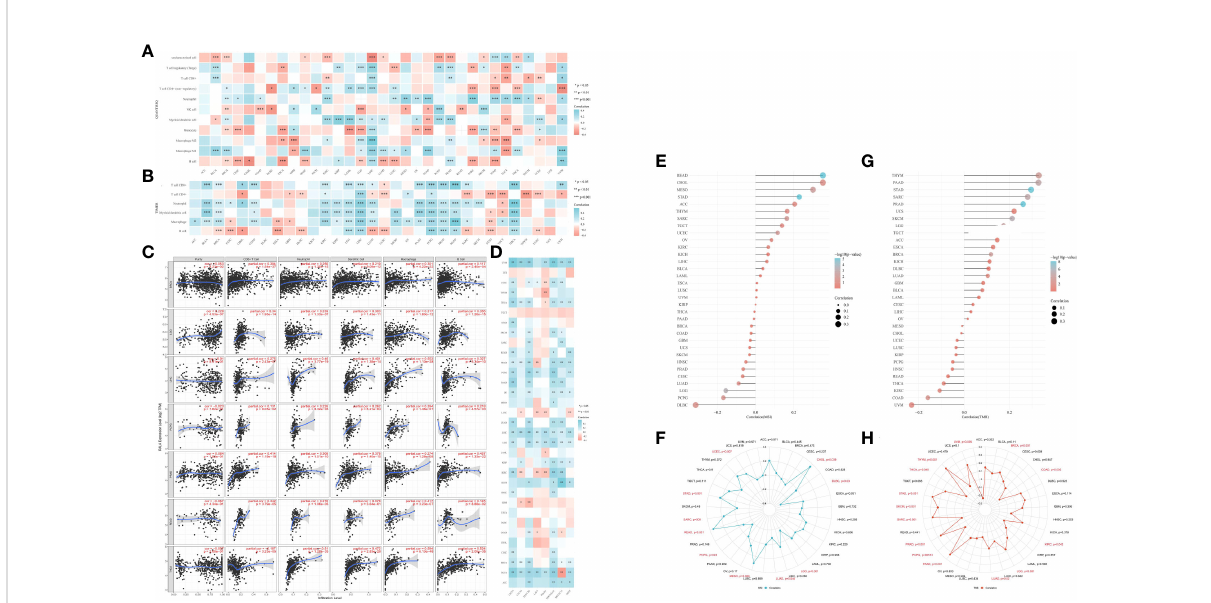
FIGURE 4 Immune in fi ltration of RALA in TME. (A, B) The heatmap of immune score and expression of RALA in multiple tumor tissues. The abscissa represents different tumor tissues, and the ordinate represents different immune score. (C) Correlation between RALA and tumor tissue abundance of immune in fi ltrates in the TIMER database. (D) Expression heat map of immune checkpoint related genes in pan-cancerous tissues, in which abscissa represents different immune checkpoint genes and ordinate represents different tumor tissues. (E) Lollipop chart and (F) Radar Diagram describing Spearman Correlation Analysis of MSI and RALA Expressions. (G) Lollipop chart and (H) Radar Diagram describing Spearman Correlation Analysis of TMB and RALA Expressions. *p<0.05, **p<0.01,